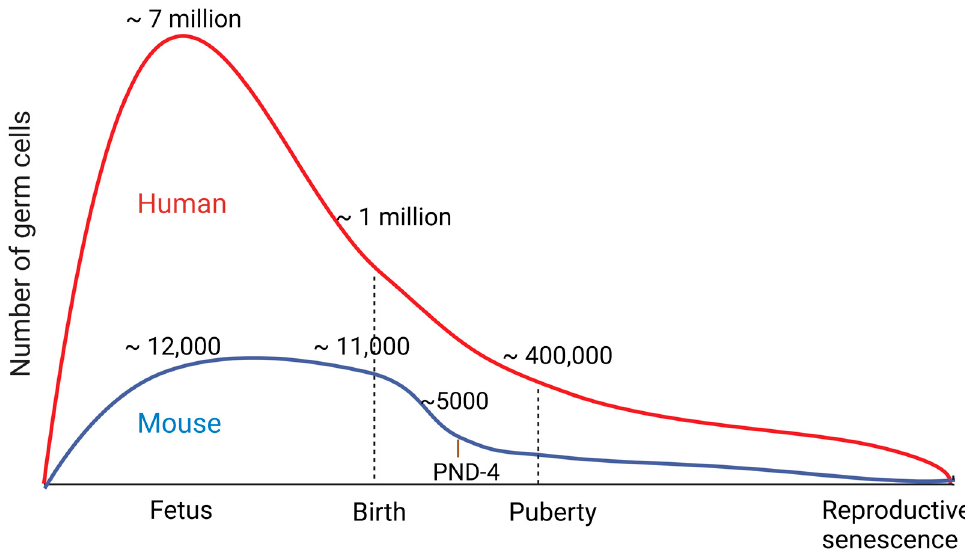
Figure 1. Graphical representation of germ cell quantities in mouse and human ovaries at various stages of the reproductive lifespan. Germ cells are most abundant during the fetal stage. In mice, the greatest loss is seen within the first few days following birth, whereas in humans, substantial germ cell death takes place before birth. Between birth and puberty, there is a second wave of significant decline in the number of oocytes. Once the oocytes are exhausted, the ovaries enter reproductive senescence. PND: Postnatal day.